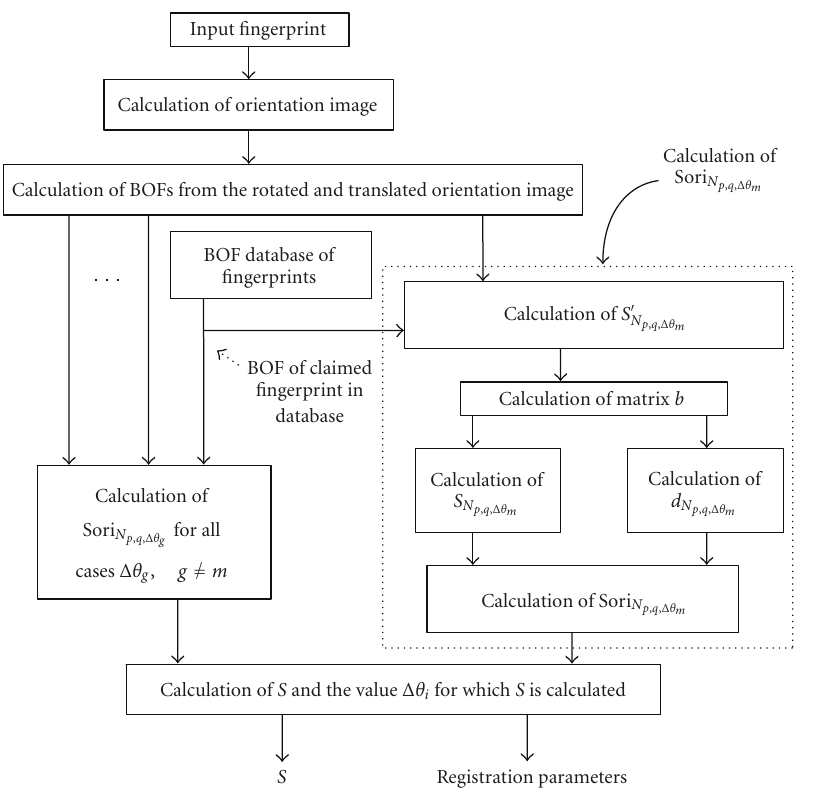
Figure 1: Block diagram of proposed orientation-based fingerprint similarity